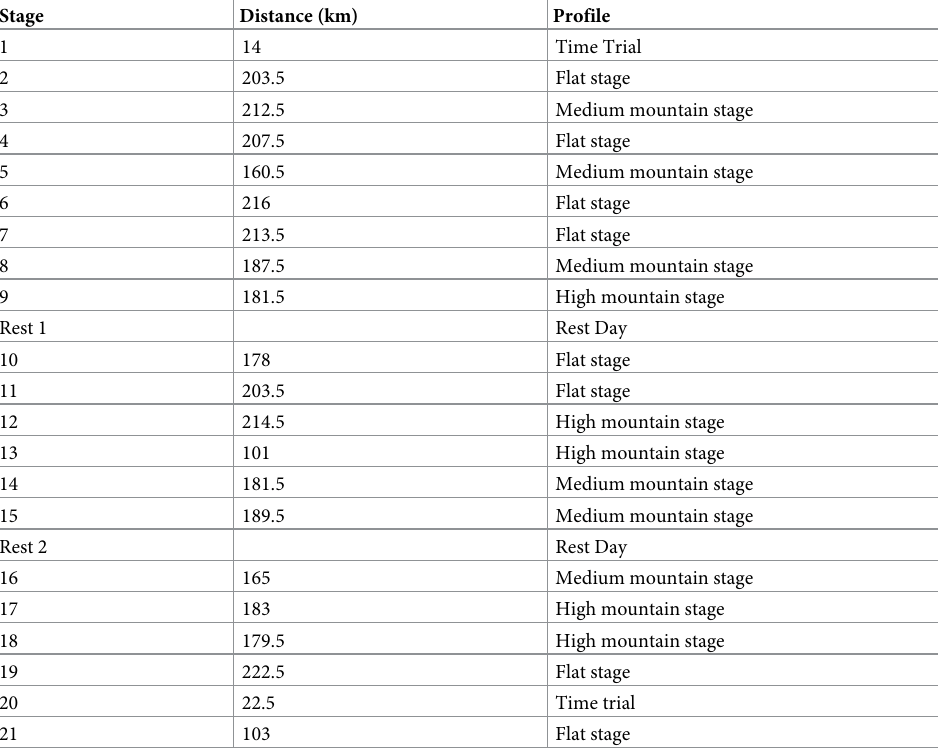
Table 1. Characteristics of the 2017 Tour de France